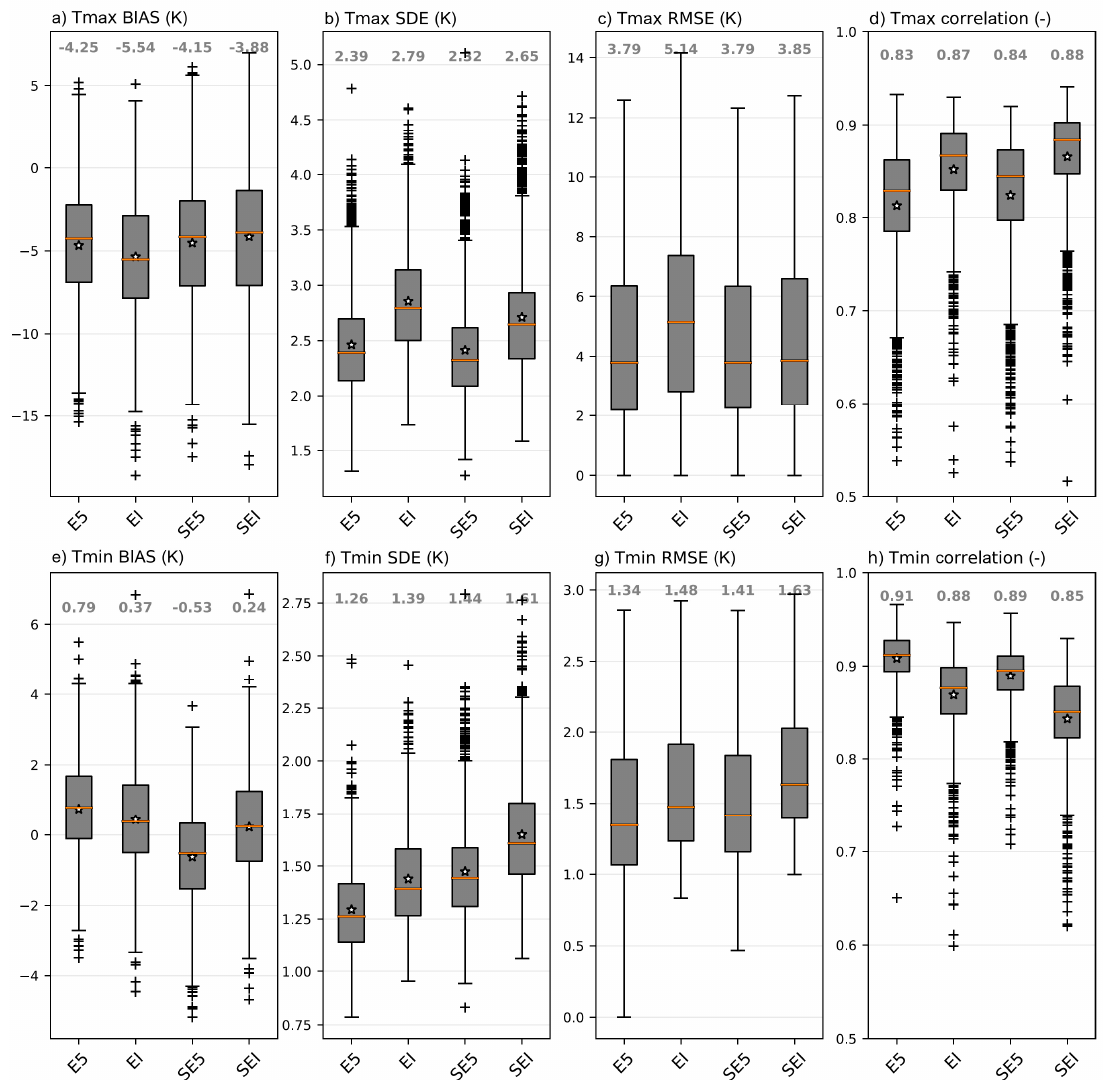
Figure 3. Distributions of LST Tmax (Tmin) mean error ( a , e ), standard deviation of the error ( b , f ), root mean square error ( c , g ) and temporal correlation ( d , h ) in: ERA5 (E5), ERA-Interim (EI) and the simulations forced with E5 (SE5) and EI (SEI). The red line indicates the median, the filled box represents the interquartile range (25th to 75th percentiles), the whiskers indicate the 10th and 90th percentiles, the white stars the mean, and the cross markers represent outliers. The number above each boxplot is the median of that boxplot. Note the di ff erent vertical scales between the Tmax (top) and Tmin (bottom) panels.